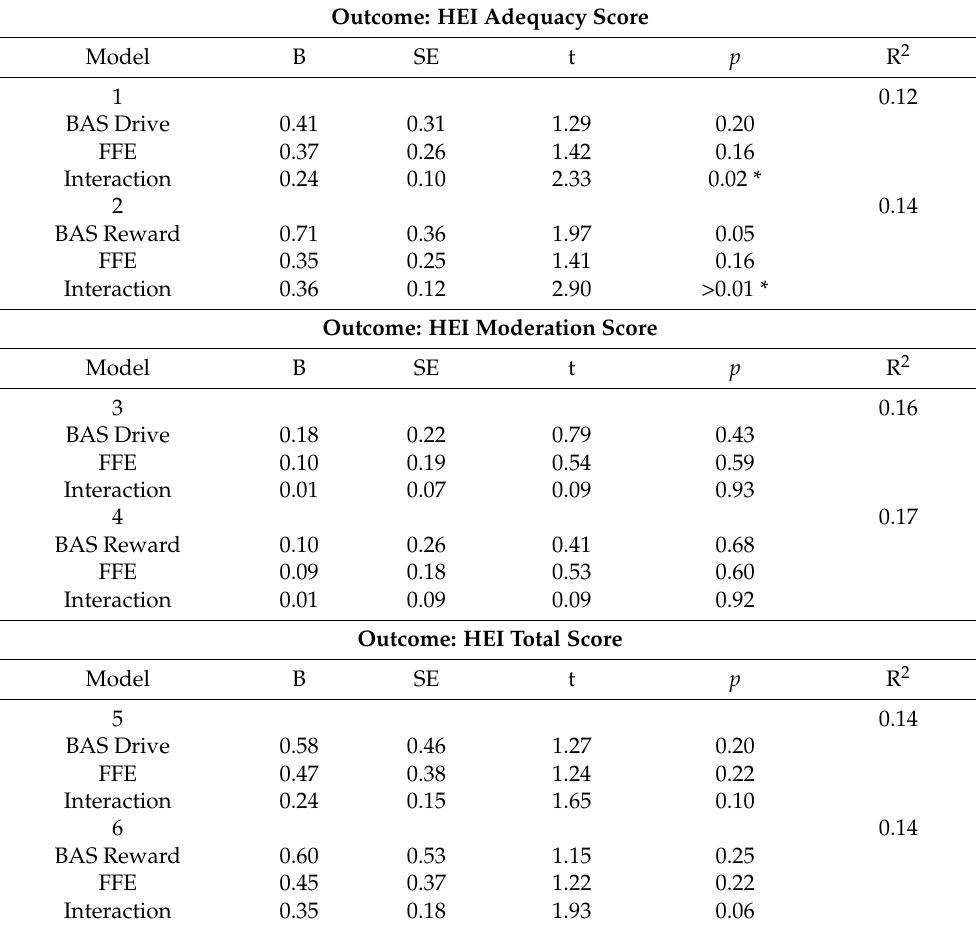
Table 2. Summary of multiple regressions of approach motivation and fast-food environment (FFE) in relation to HEI